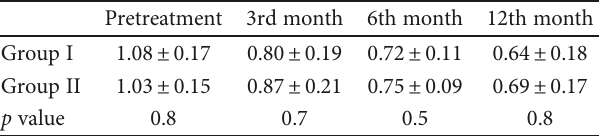
Table 2: Central macular thickness (CMT) measured by OCT in both groups.